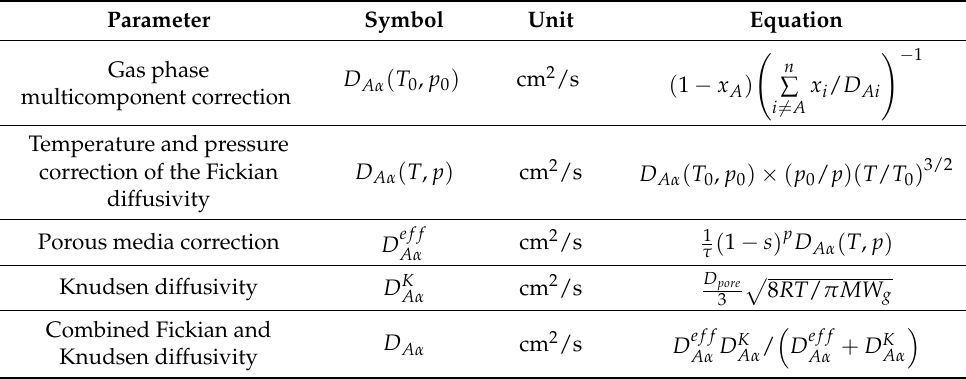
Table 1. Diffusivity constitutive